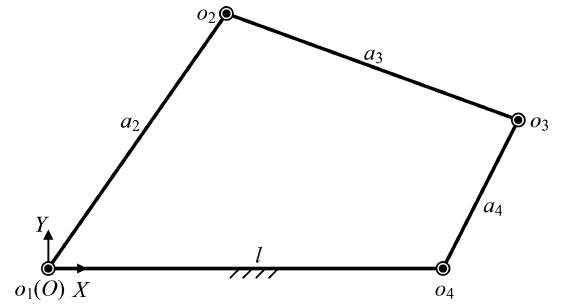
Figure 10. The schematic diagram of the simplified mechanism.